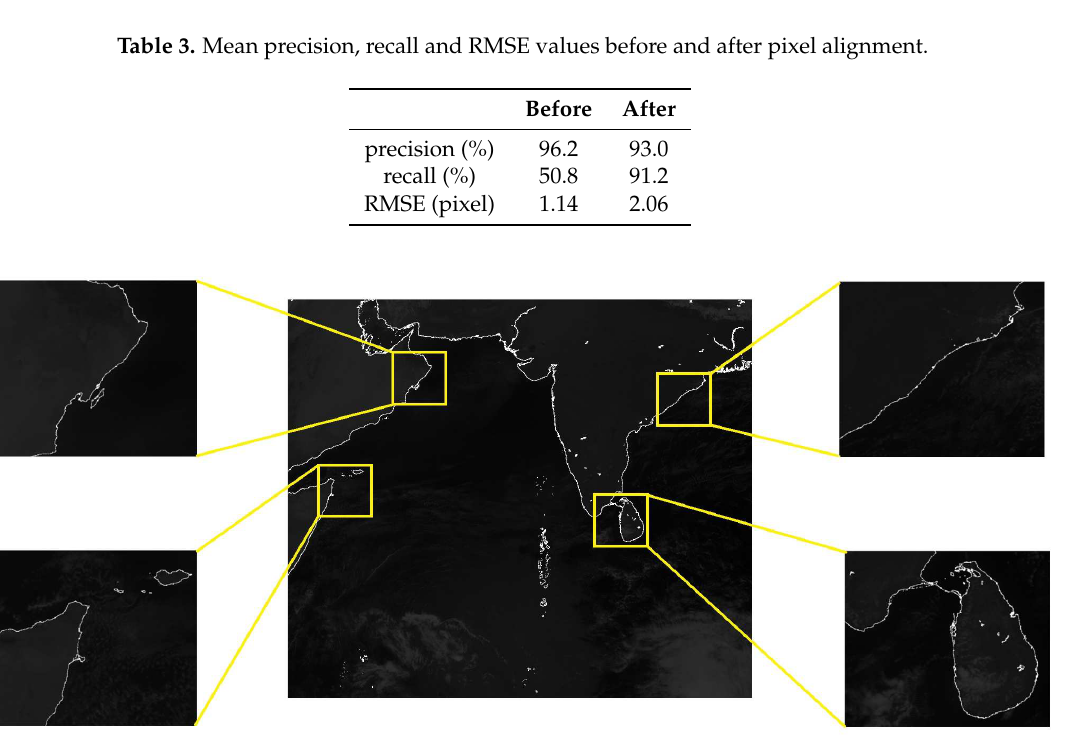
Figure 8. Pixel alignment